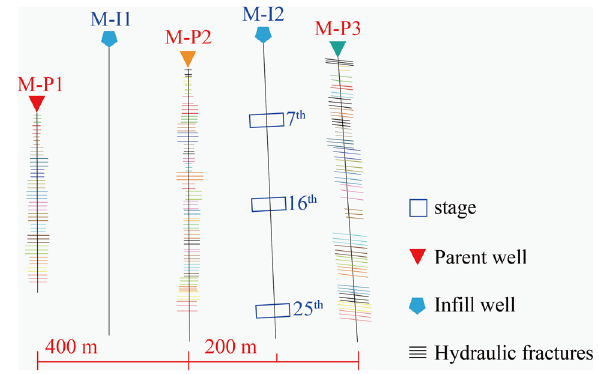
Fig. 2 Geometric model for the studied well